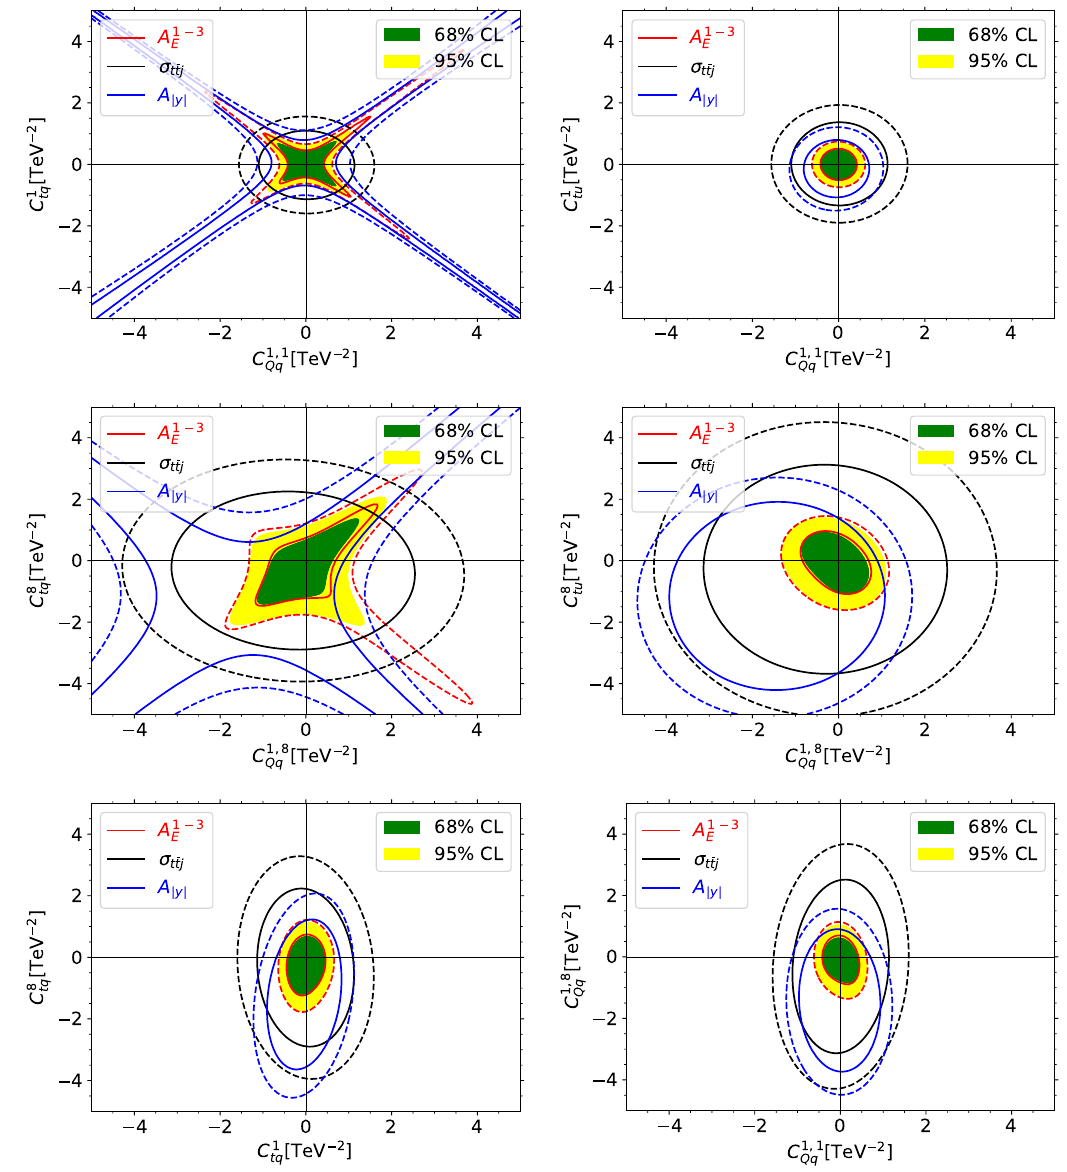
Figure 6 . Expected bounds on Wilson coe(cid:14)cients from two-parameter (cid:12)ts of the energy asymmetry A opt in all three (cid:18) j bins (red) and the cross section (cid:27) in the boosted regime (black) to LHC t (cid:22) tj E Run-2 data. For comparison, we show existing bounds from the latest Run-2 measurement of the rapidity asymmetry A in t (cid:22) t production [29] (blue). Solid and dashed lines mark the 68% and 95% j y j con(cid:12)dence levels for each observable. Green and yellow regions show the 68% and 95% CL limits of a combined (cid:12)t to all (cid:12)ve